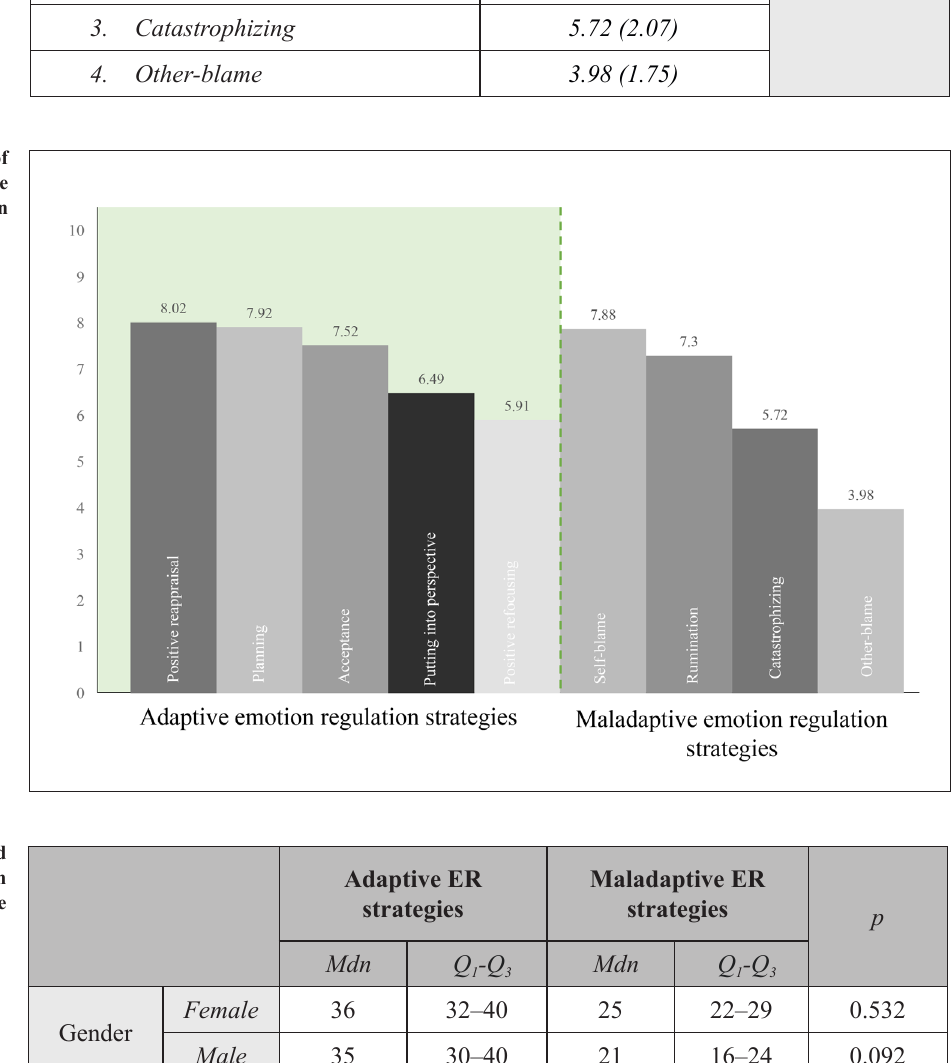
Figure 5. Comparison of adaptive and maladaptive emotion regulation strategies